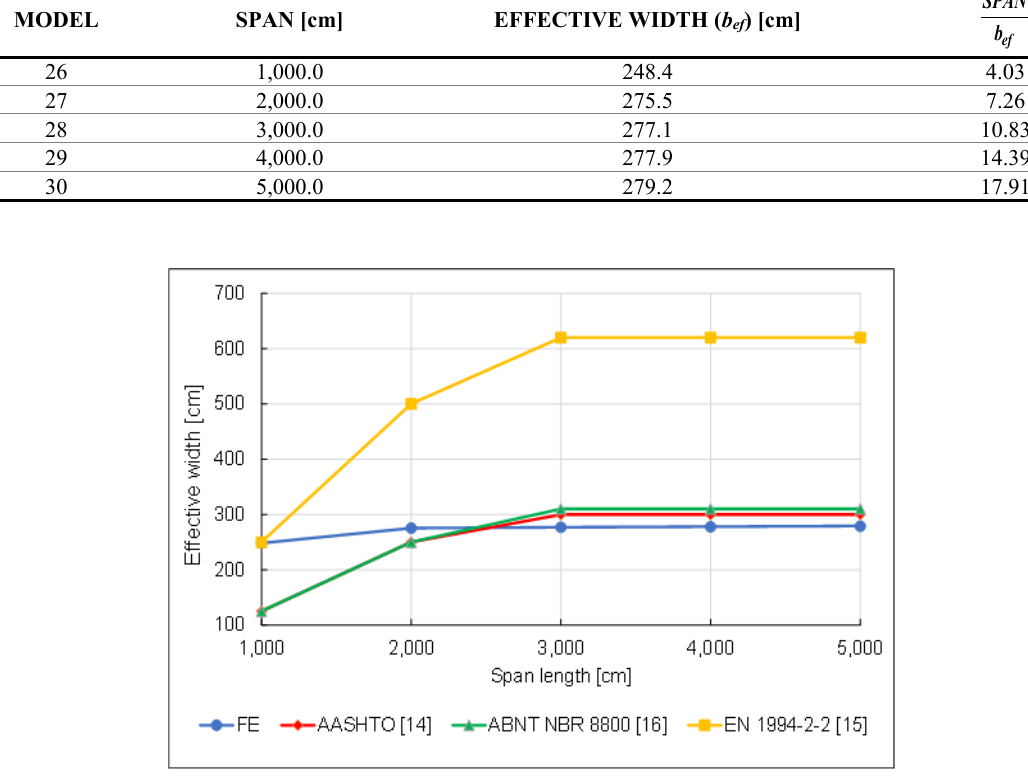
Figure 17. Effective width versus span length for double box configuration.